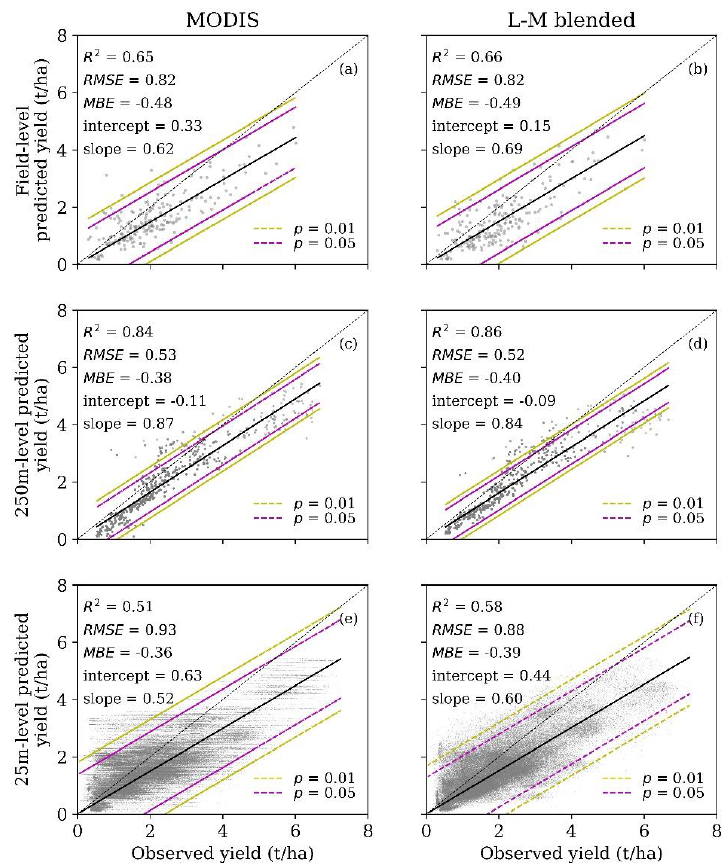
Figure 5. Validation of C-Crop-predicted yield pooled for wheat, barley, and canola using MODIS and L – M blended data when the complete Landsat time series are not available (the fraction of missing Landsat series ≥0.083). From top to bottom, the first ( a and b ), second ( c and d ), and third ( e and f ) rows show the comparison between observed ( x -axis) and model-predicted yields ( y -axis) on the field scale ( n = 210), 250-m pixel level ( n = 3978), and 25-m pixel level ( n = 231,667), respectively, where n is the sample size. From left to right, the first (a, c, and e) and second (b, d, and f) columns delineate the validation using MODIS and L – M blended data, respectively. The solid black line is the line of best fit, the purple and the yellow lines represent the upper and lower bounds of the prediction confidence intervals (i.e., p = 0.01 and p = 0.05), and the black dashed line is the 1:1 line.